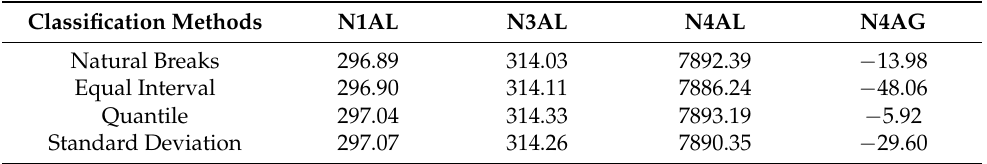
Table 2. Performances of the classification methods for the flood vulnerability indexes based on the different normalizations and aggregation techniques. N1 = Min-max normalization, N2 = Z-scores normalization, N3 = distance to target normalization, N4 = ranking normalization, AL = linear aggregation, and AG = geometric